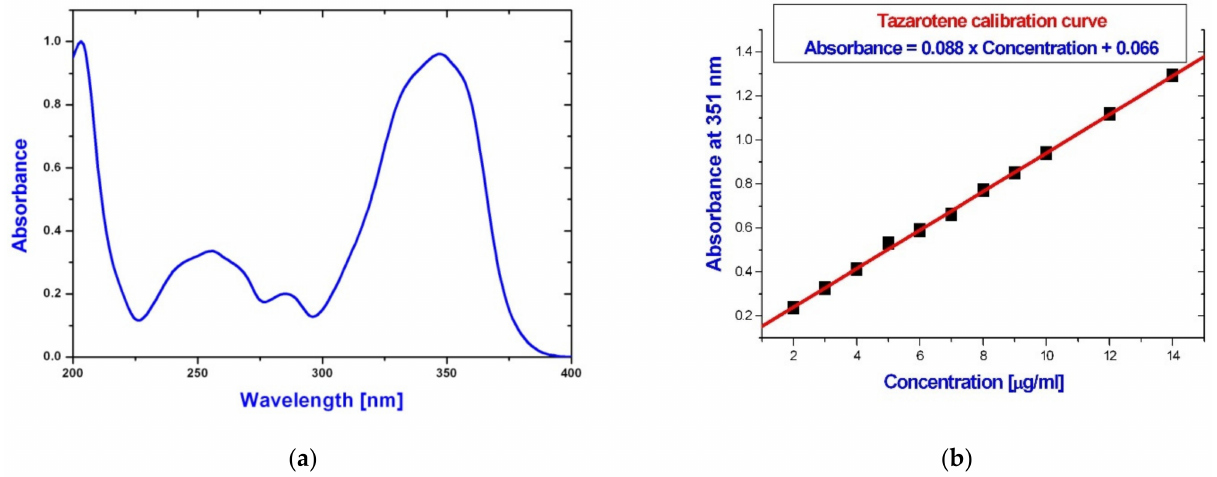
Figure 6. ( a ) UV–Vis absorption spectra of tazarotene; ( b ) calibration curve at wavelength of 351